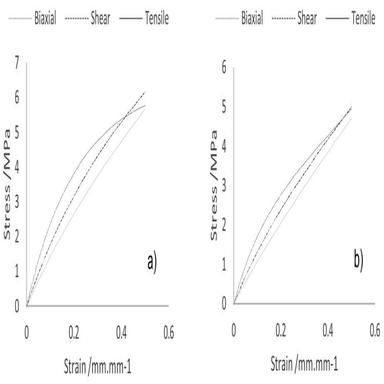
Graphs showing combined fit for: a) Primary response, b) Stabilised response.